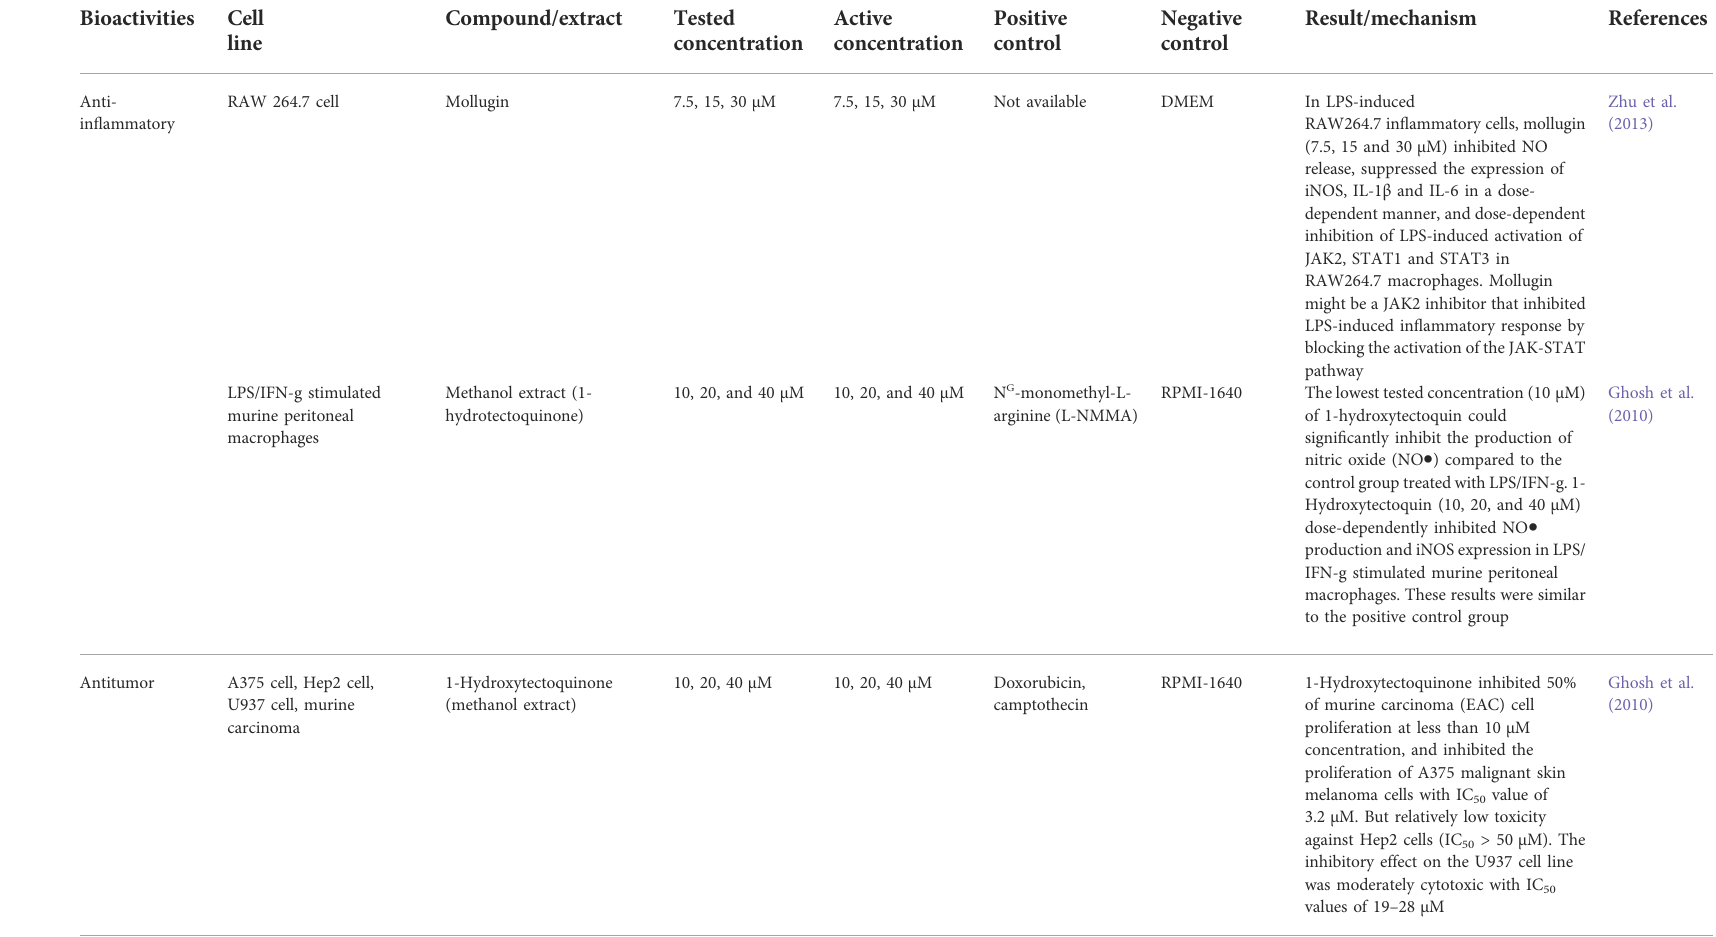
TABLE 2 ( Continued ) In vitro study on the pharmacological effects of R.